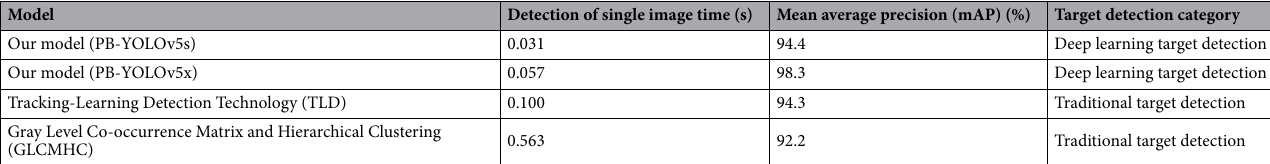
Table 7. Comparison between this study and other particle board surface defect detection